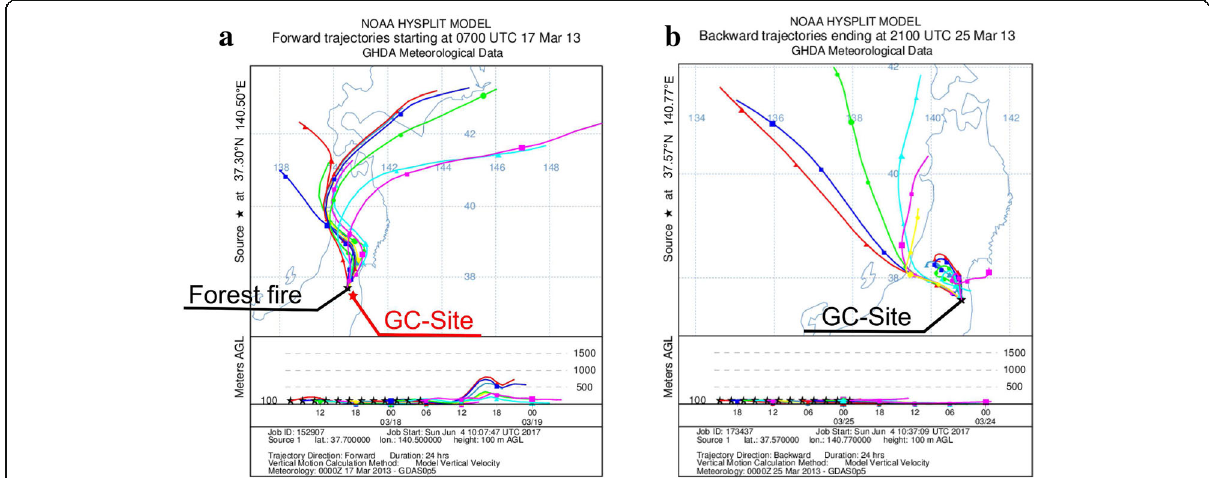
Fig. 9 Maps show the forward and backward trajectories calculated with NOAA HYSPLIT model (Stein et al. 2015) during the forest fire event. a The forward trajectories from Ootaki (forest fire area), which are calculated from March 17 at 16:00 (LT) to March 18 at 13:00 (LT). b Backward trajectories from the measurement site (GC), which are calculated from March 24 at 13:00 (LT) to March 25 at 13:00